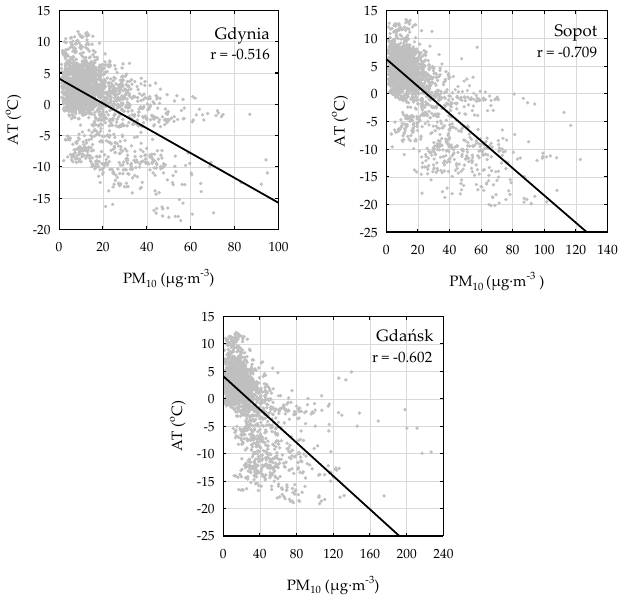
Figure 3. The correlation between the air temperature and PM 10 concentrations in Sopot and Gdańsk during the winter seasons of 2011/12.